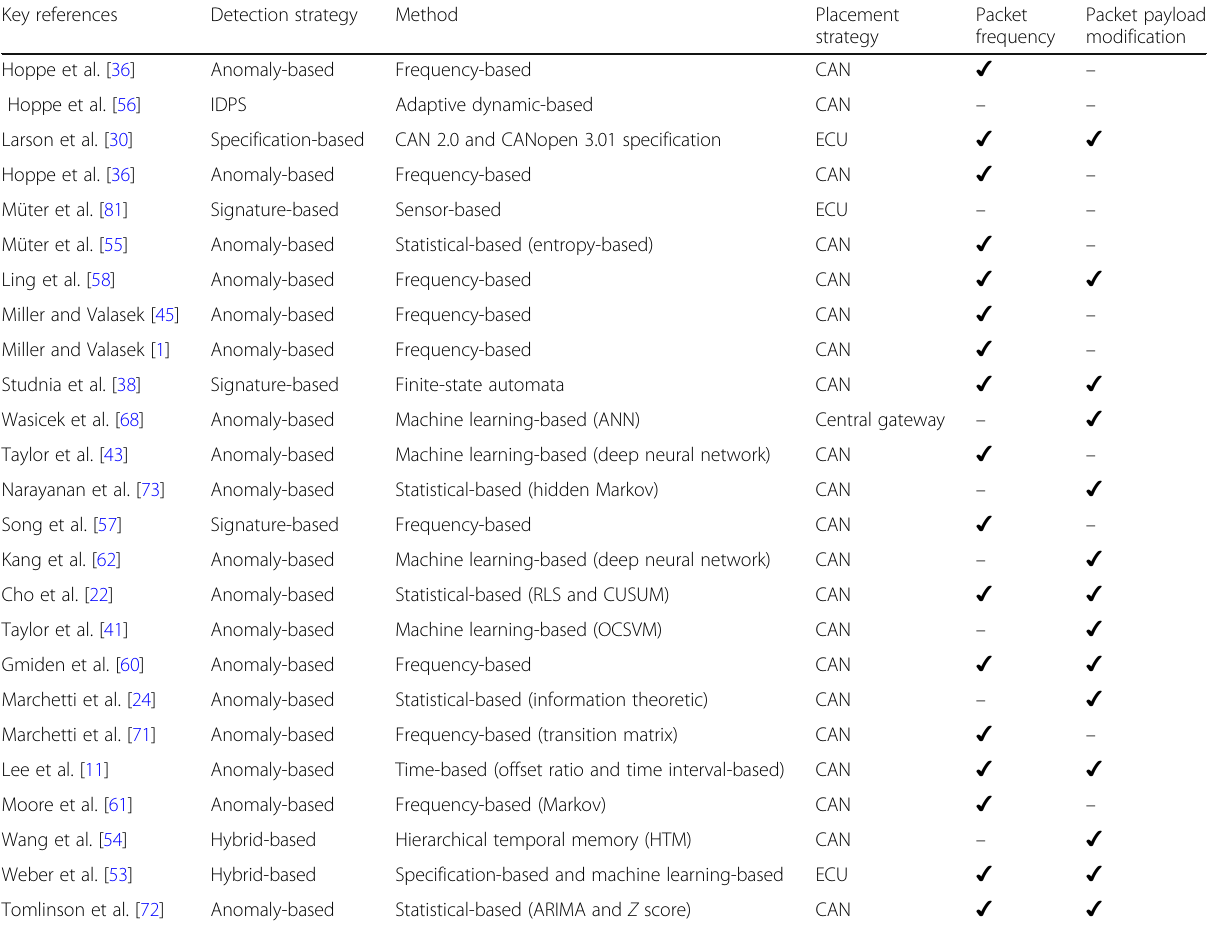
Table 1 Summary of the IDS for CAN bus system literature in the automotive domain. IDS detection strategy methods are proposed based on how the attack manifest into CAN bus network: Manipulation on CAN frequency and CAN packet